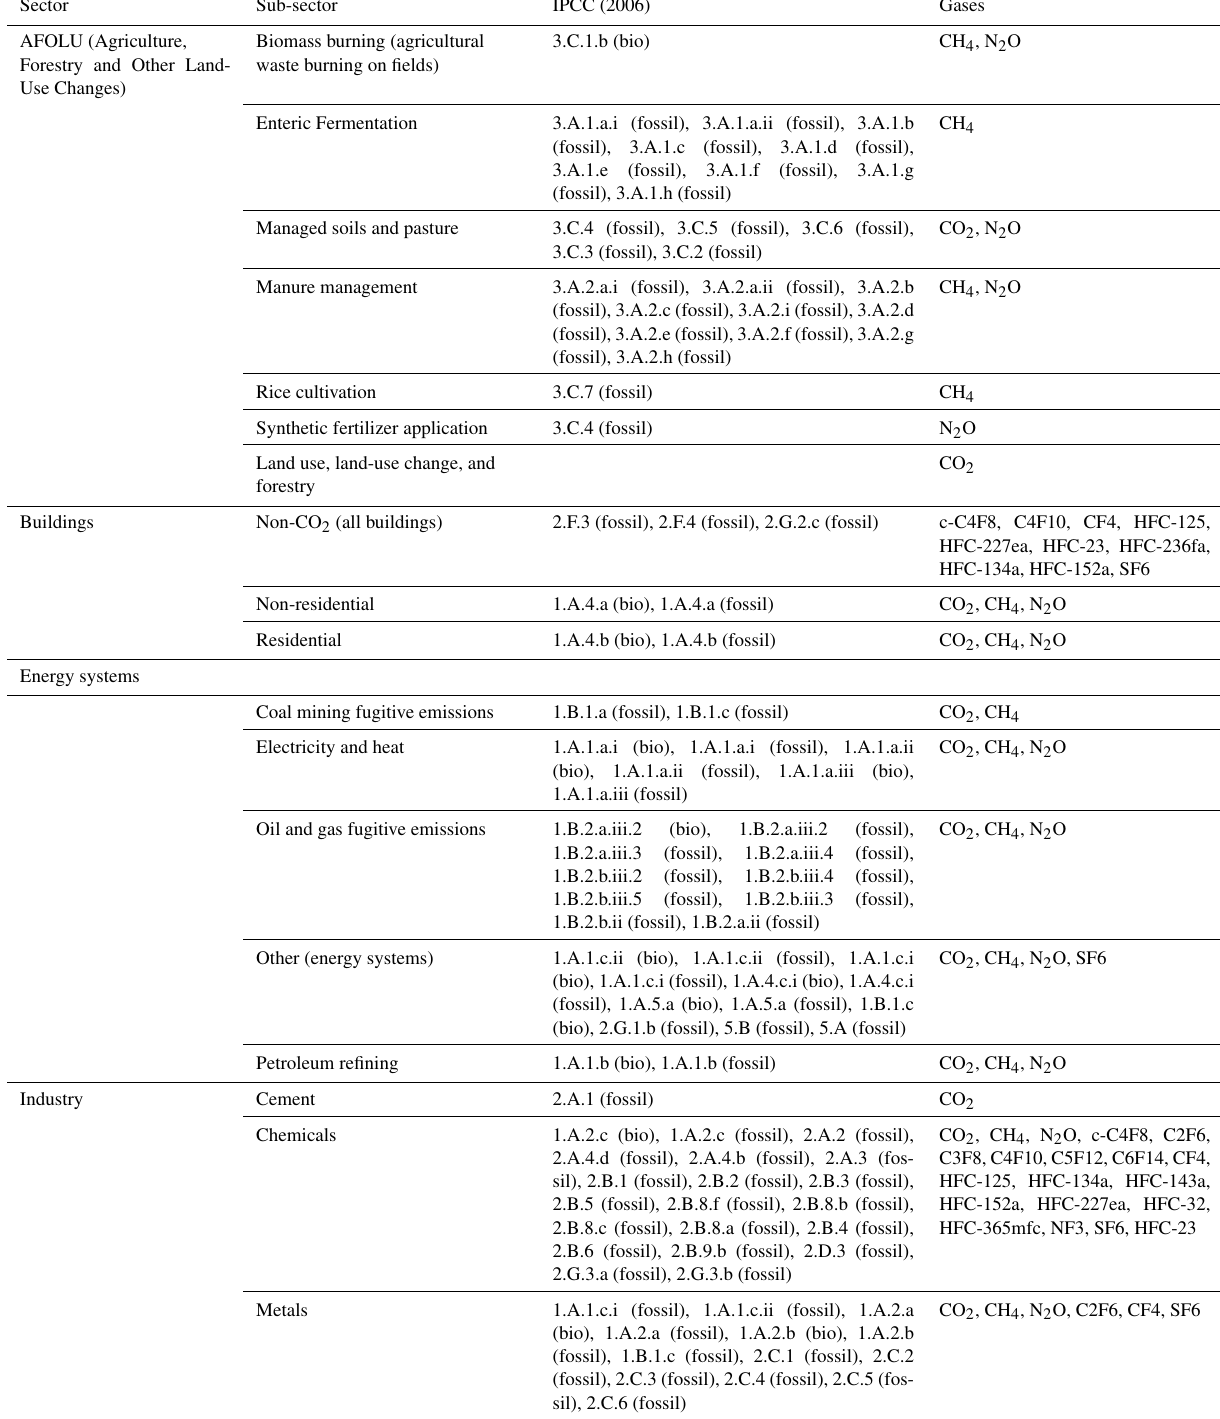
Table 2. Overview of the two-level sector aggregation with reference to assigned source/sink categories conforming to the IPCC reporting guidelines (IPCC, 2006, 2019) as well as relevant GHGs. Note that EDGAR v6 distinguishes between biogenic CO 2 and CH 4 sources with a “bio” label, with all other sectors “fossil” by default, even if that source is not related to fossil fuel activities. The fossil/bio label is hence not descriptive in nature. Two HCFC gases (denoted with ∗ ) are included in the dataset, despite being neither PFCs nor HFCs (and hence regulated under Montreal). This is to preserve consistency with current and previous versions of EDGAR, which include these gases. Their total warming effect is low ( ∼ 10MtCO 2 eq . in 2019), and the major HCFC sources are not